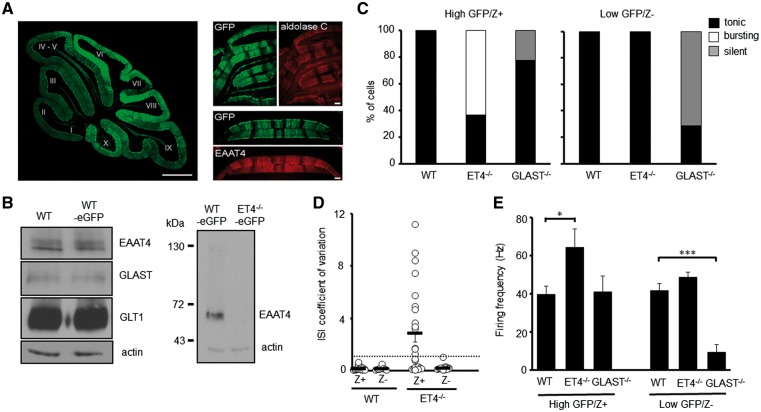
Modes of intrinsic PC firing correlate with differential expression profiles of EAAT4. (A) Left, mid-sagittal cerebellar section from a fluorescent reporter BAC mouse in which eGFP (green) cDNA is under the control of the EAAT4 promoter. Bar, 500 µm. Right, coronal cerebellar sections from WT-eGFP (green) reporter mouse immunostained for either aldolase C (red) or EAAT4 (red). Bar, 50 µm. (B) Immunoblot analyses of EAAT protein levels in cerebellar homogenates from WT, WT-eGFP and ET4–/–-eGFP mice. (C) Ratio of high GFP (Z+) and low GFP (Z–) expressing PCs in WT-eGFP (n = 35), ET4–/–-eGFP (n = 33) and GLAST–/–-eGFP (n = 16) mice that fire tonically, burst fire or are silent. (D) Coefficient of variation of ISI for WT-eGFP and ET4–/–-eGFP PCs. Dotted line depicts CV = 1. (E) Spontaneous firing frequency of high GFP (Z+) and low GFP (Z–) expressing PCs in WT-eGFP, ET4–/–-eGFP and GLAST–/–-eGFP mice. Mean ± SEM.